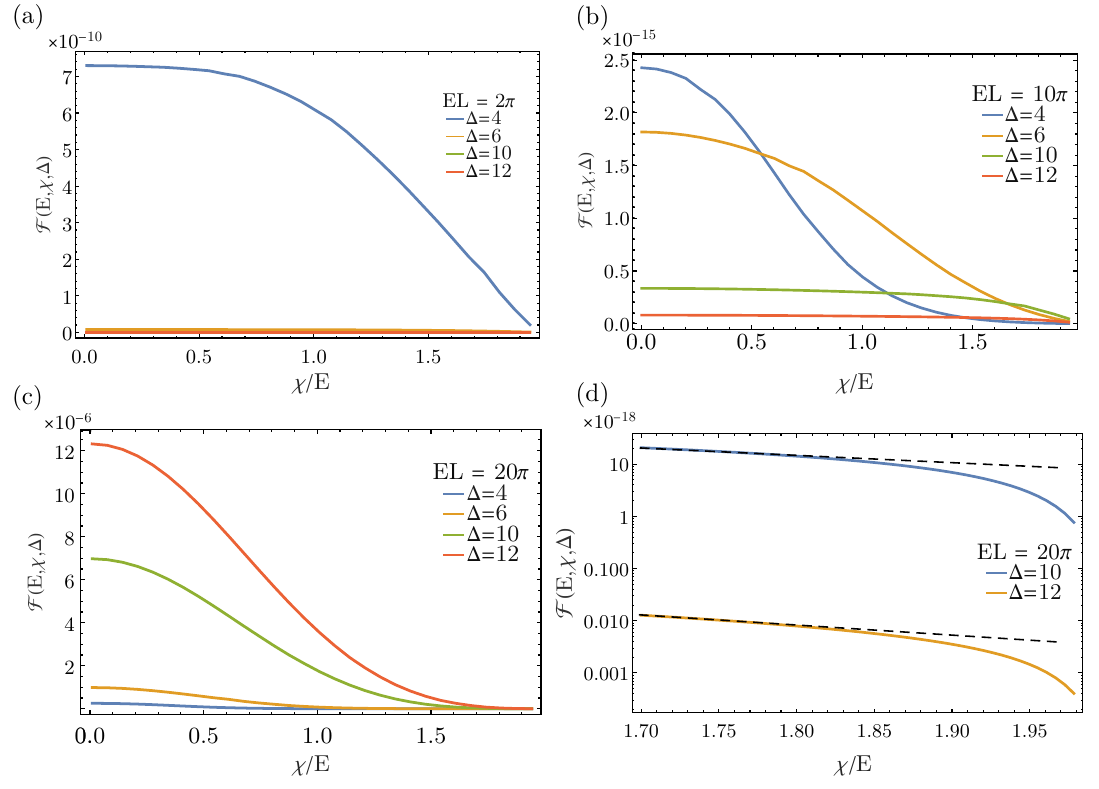
Figure 2 . (a), (b) and (c) show the average of the square of matrix elements F ( E; (cid:31); (cid:1)) of scalars primary of various dimensions (cid:1) as a function of the energy di(cid:11)erence of the states. Computed numerically from eqs. (2.34), (2.35) and (2.32) with c = 20. (d) shows the tails of F ( E; (cid:31); (cid:1)) near (cid:31) (cid:24) 2 E in logarithmic-linear scale. Dashed lines are a guide to they eye suggesting the exponential suppression observed in the context of ETH in one-dimensional systems [26,